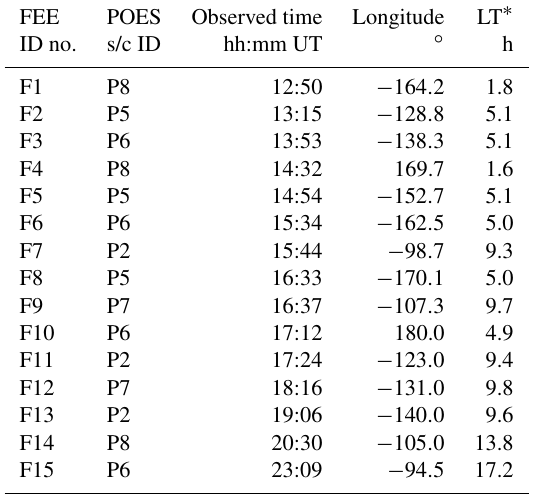
Table 1. FEE enhancements observed by POES